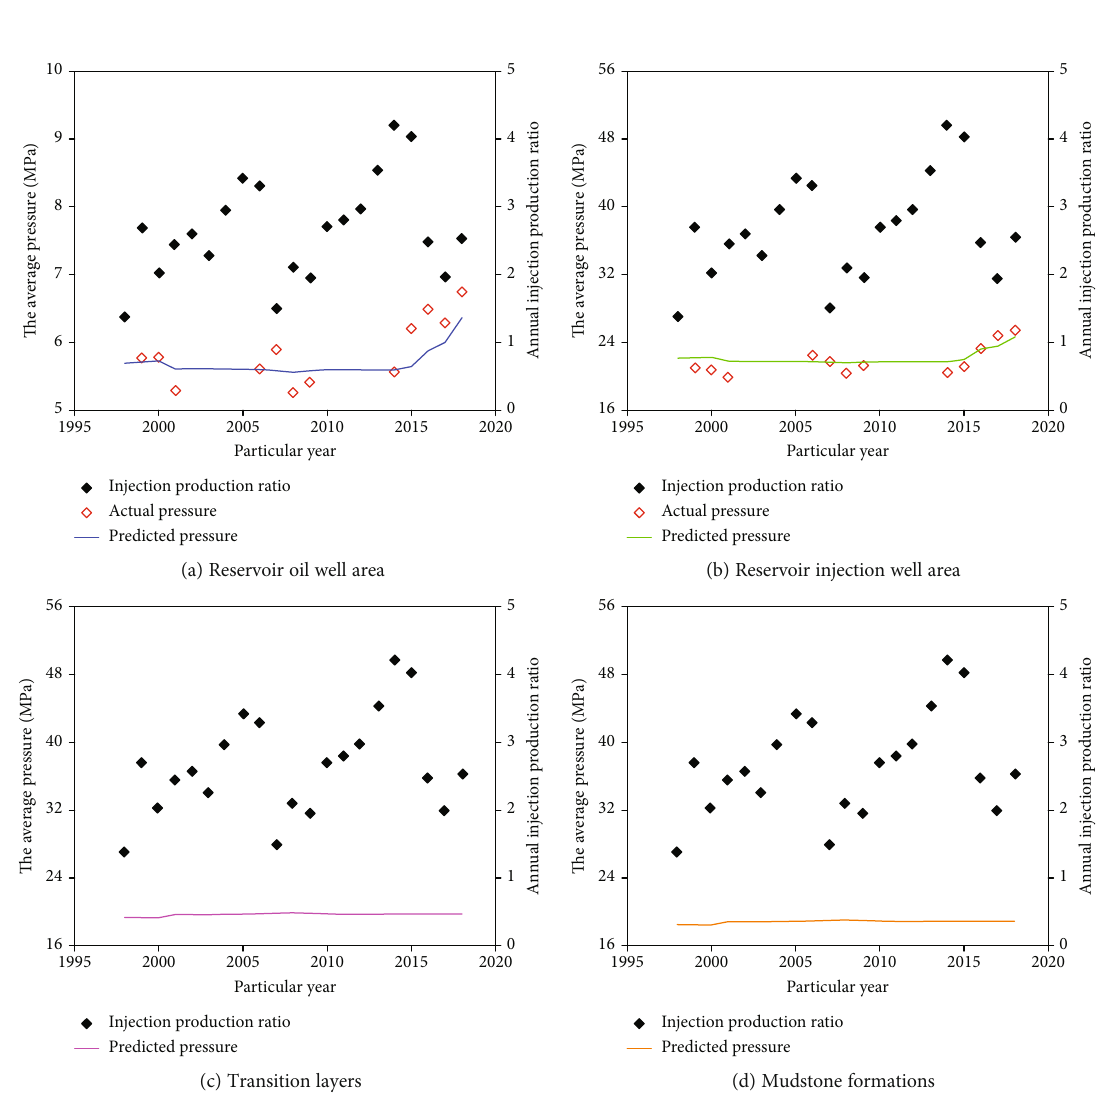
Figure 9: Production data validation results of the new pressure prediction